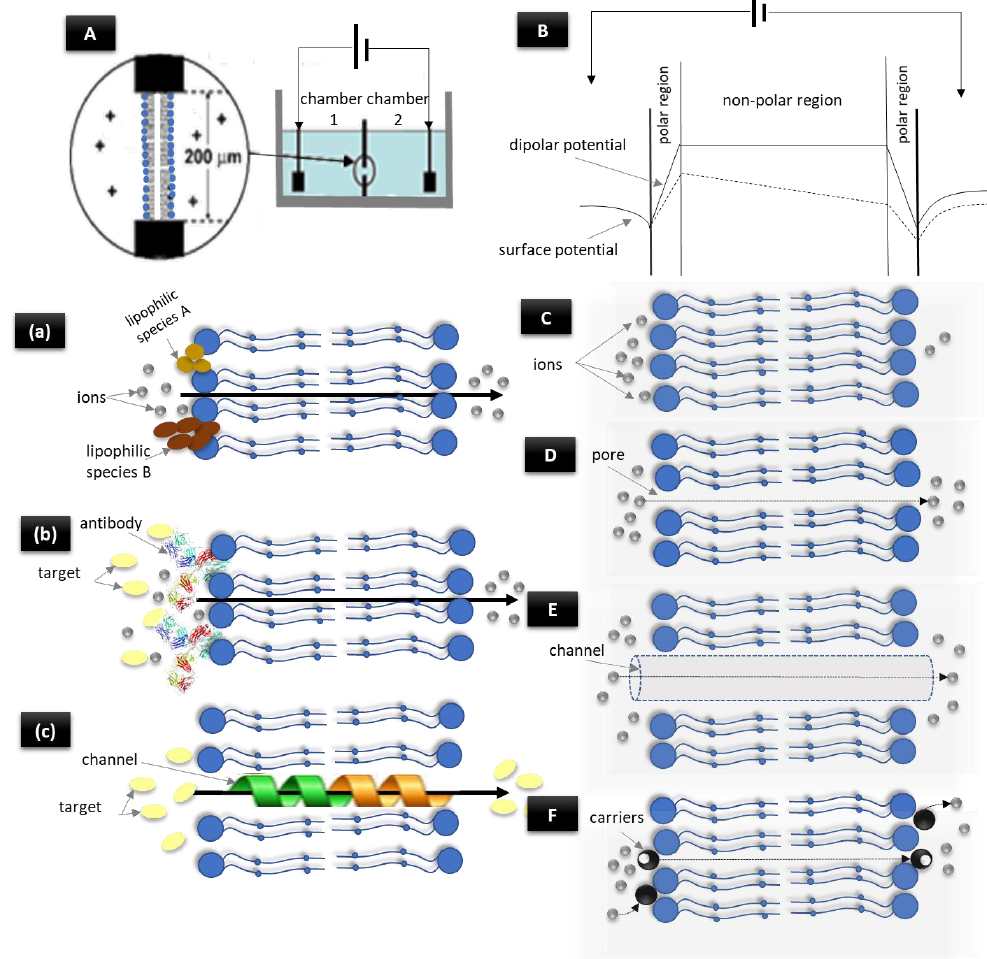
Figure 3. The electroanalytical aspect of artificial bilayer lipid membranes: Simplified schematic of the experimental set-up ( A ); potential distribution across the bilayer ( B ); overview of the principle mechanisms for signal generation ( C – F ); and the main biosensing strategies employed ( a – c ). For details see